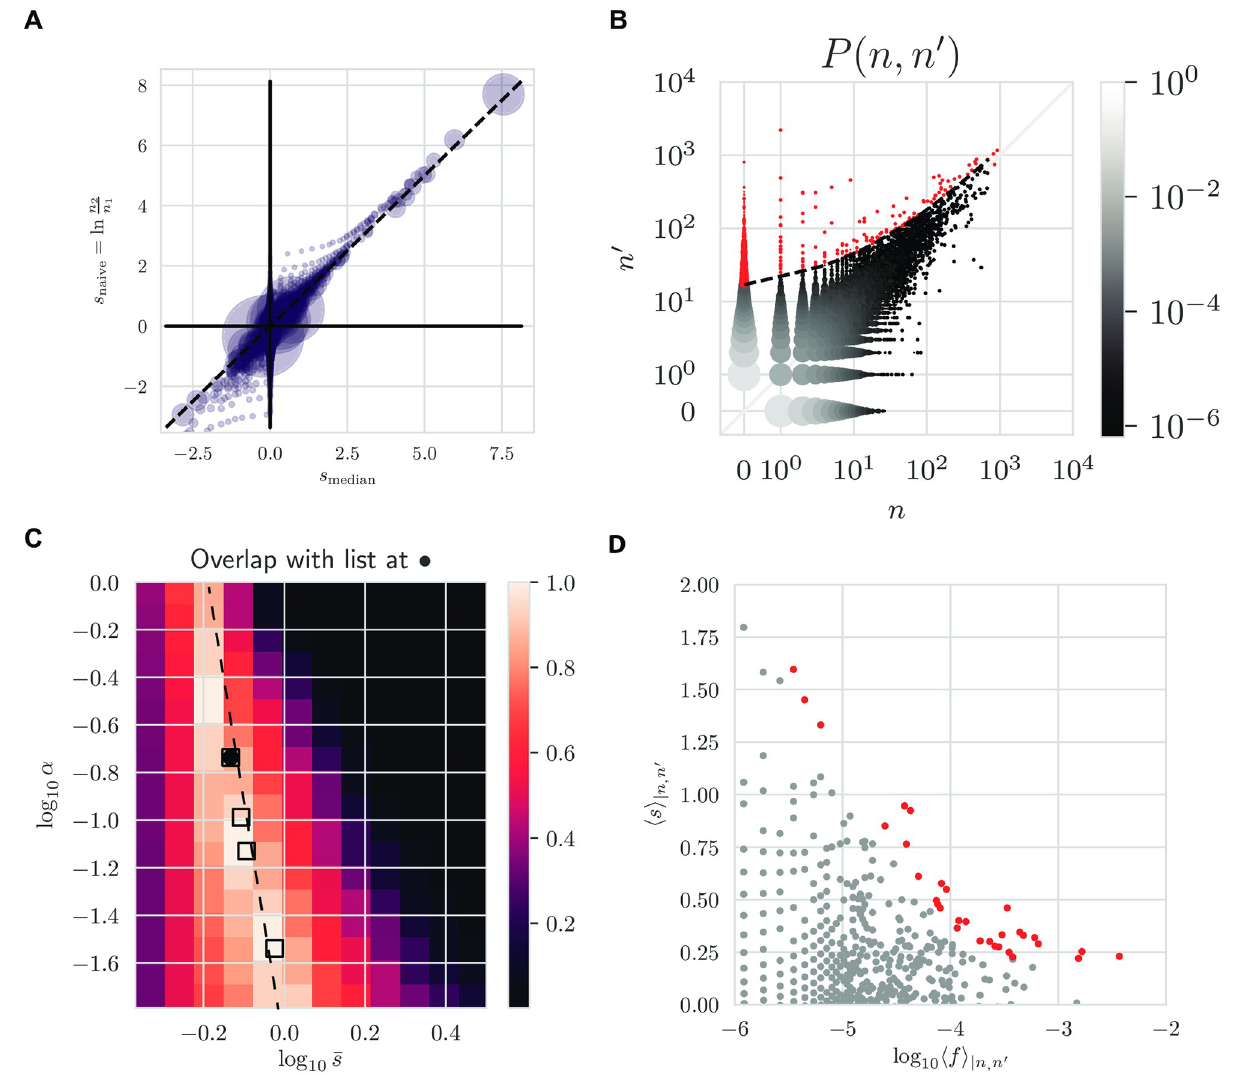
Fig 7. Identifying responding clones. (A) Summary statistics of log-frequency fold-change posterior distributions. Comparison of the posterior median log-frequency fold-change and the naive estimate, log n 0 / n (across clones with n , n 0 > 0). Each circle is a ( n , n 0 ) pair with size proportional to pair count average ( n + n 0 )/2. (B) The same threshold for significant expansion in ( n , n 0 )-space with identified clones highlighted in red. (C) The optimal values of α and � s for donor S2 and day-0 day-15 comparison for 3 replicates (square markers). The background heat map is the list overlap (the size of the intersection of the two lists divided by the size of their union) between a reference list obtained at the optimal ^ y (black dot) and lists exp obtained at non-optimal θ exp . (D) Mean posterior log fold-change h s i as a function of precursor ρ ( s | n , n 0 )